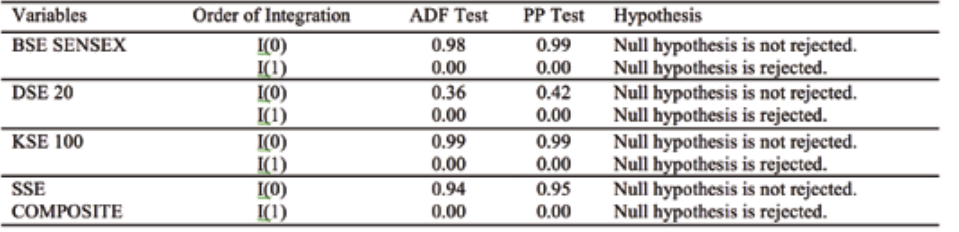
Table 2: Unit Root